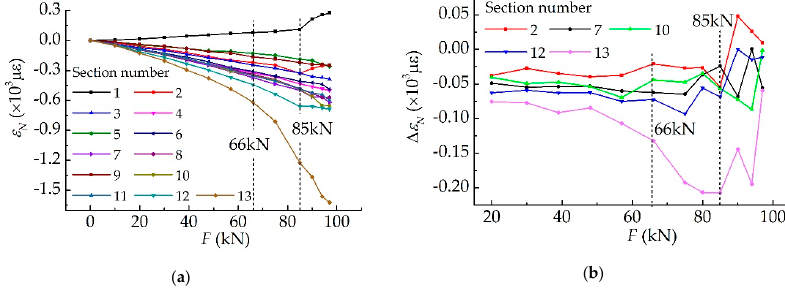
∆ ε N - F curves; ( b ) N - F